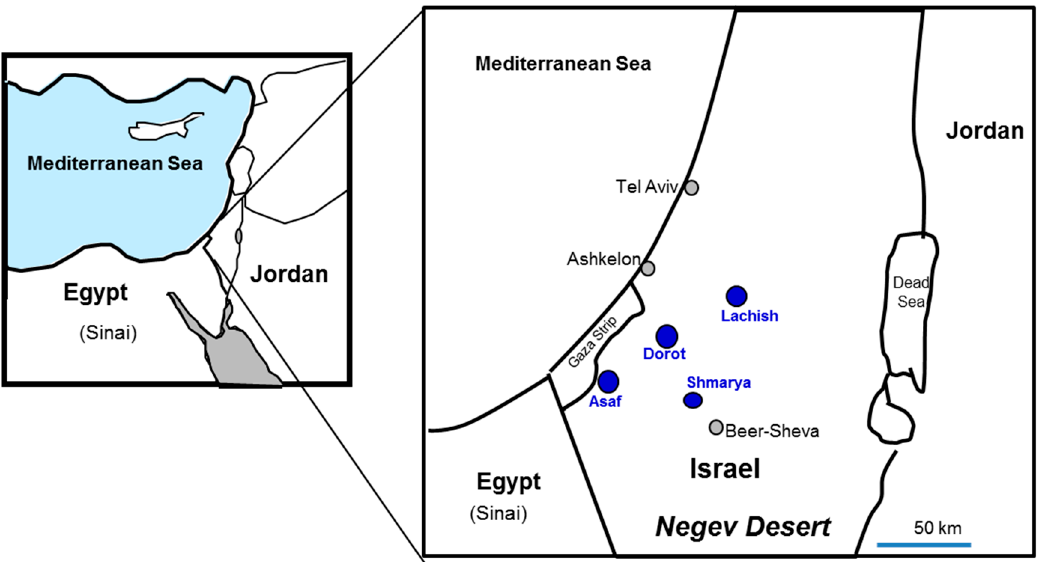
Figure 1. The location of the study sites in the northern Negev semi-arid region with annual average rainfall: Lachish (400 mm), Dorot (300 mm), Shmarya (230 mm) and Asaf (250 mm).